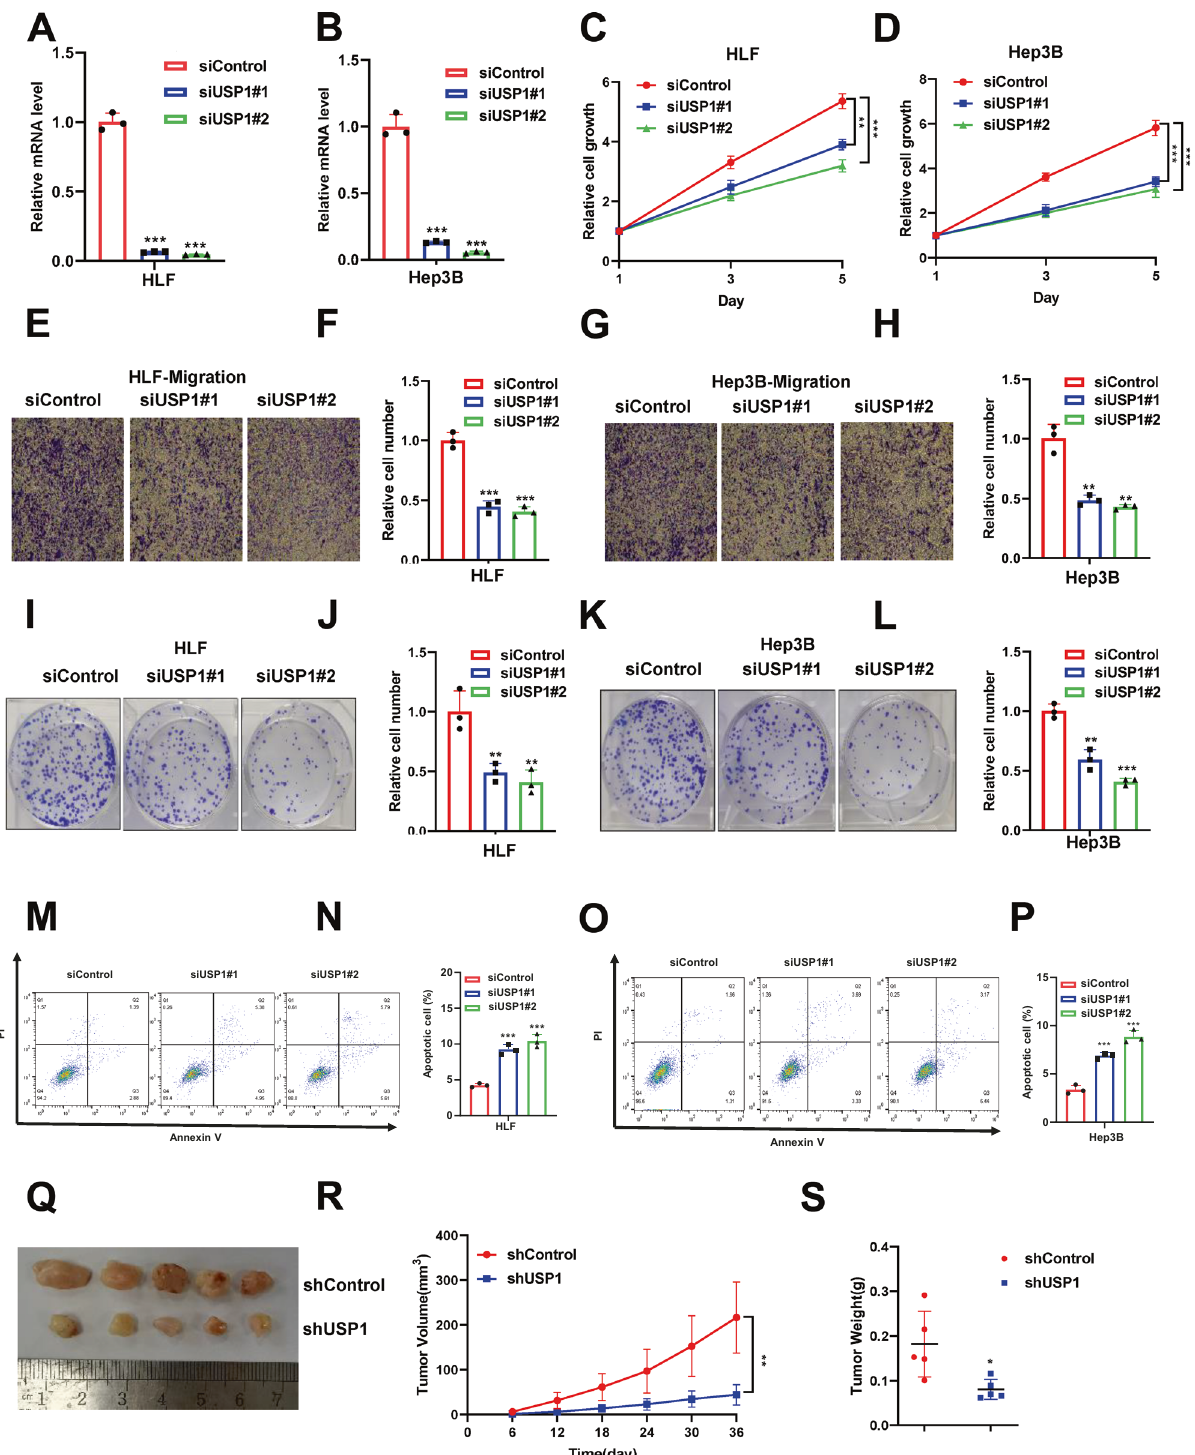
Fig. 3 USP1 depletion inhibits hepatocellular carcinoma progression in vivo and in vitro. A , B RT ‒ PCR was performed to determine USP1 mRNA levels in HLF and Hep3B cells following USP1 siRNA treatment. C , D HLF and Hep3B cells transfected with siControl or siUSP1 were tested for viability using the CCK-8 assay at the indicated time points. E – H HLF and Hep3B cells were tested for their migration ability using Transwell assays. F and H show the quantitative analysis of the colony formation assay results. I – L Colony formation (left panel) of HLF and Hep3B cells transfected with scrambled siRNA or one of two independent USP1 siRNAs. J and L show the quantitative analysis of the colony formation assay results. M – P The percentage of apoptotic cells was determined by FACS analysis after HLF and Hep3B cells were treated with USP1 siRNA. PI and Annexin V staining were performed on the cells. Q A representative image of a tumor derived from a nude mouse injected with stably transfected shControl or shUSP1 HLF cells is shown. R , S The tumor volume ( R ) and weight ( S ) in nude mice subcutaneously inoculated with stably transfected shControl or shUSP1 HLF cells. Three independent experiments were conducted to obtain the results shown in Panels A – P . All the data are presented as the means ± SDs. ** P < 0.01, *** P < 0.001 (Student ’ s t